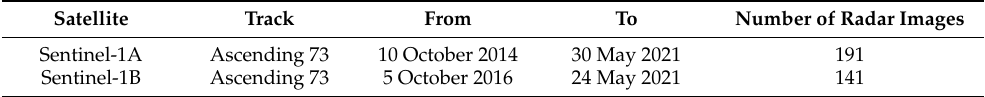
Table 1. Sentinel-1 mission data used in this